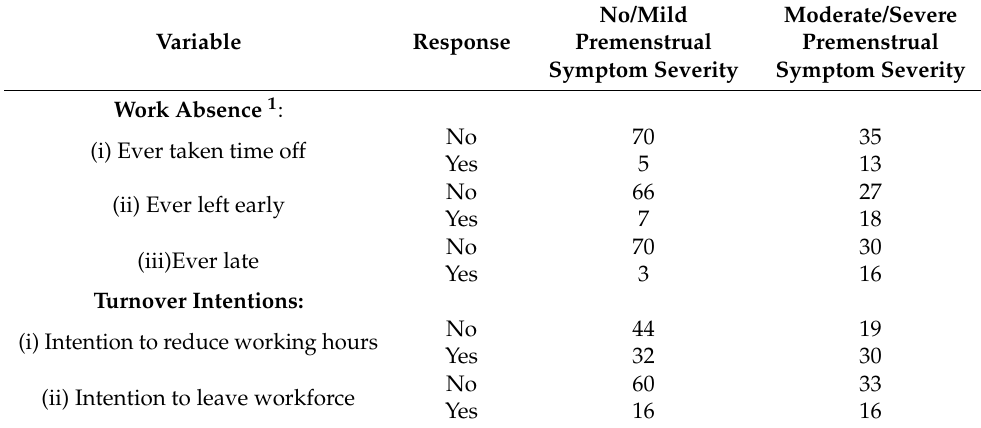
Table 2. Frequency (n’s) of responses to work absence and intentions to reduce work hours, leave the workforce. Variable Response